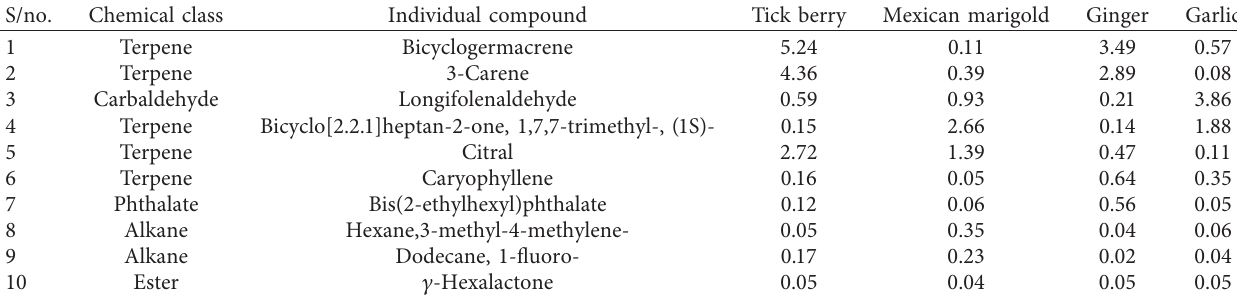
Table 3: Compounds that were present in all the tested plants.